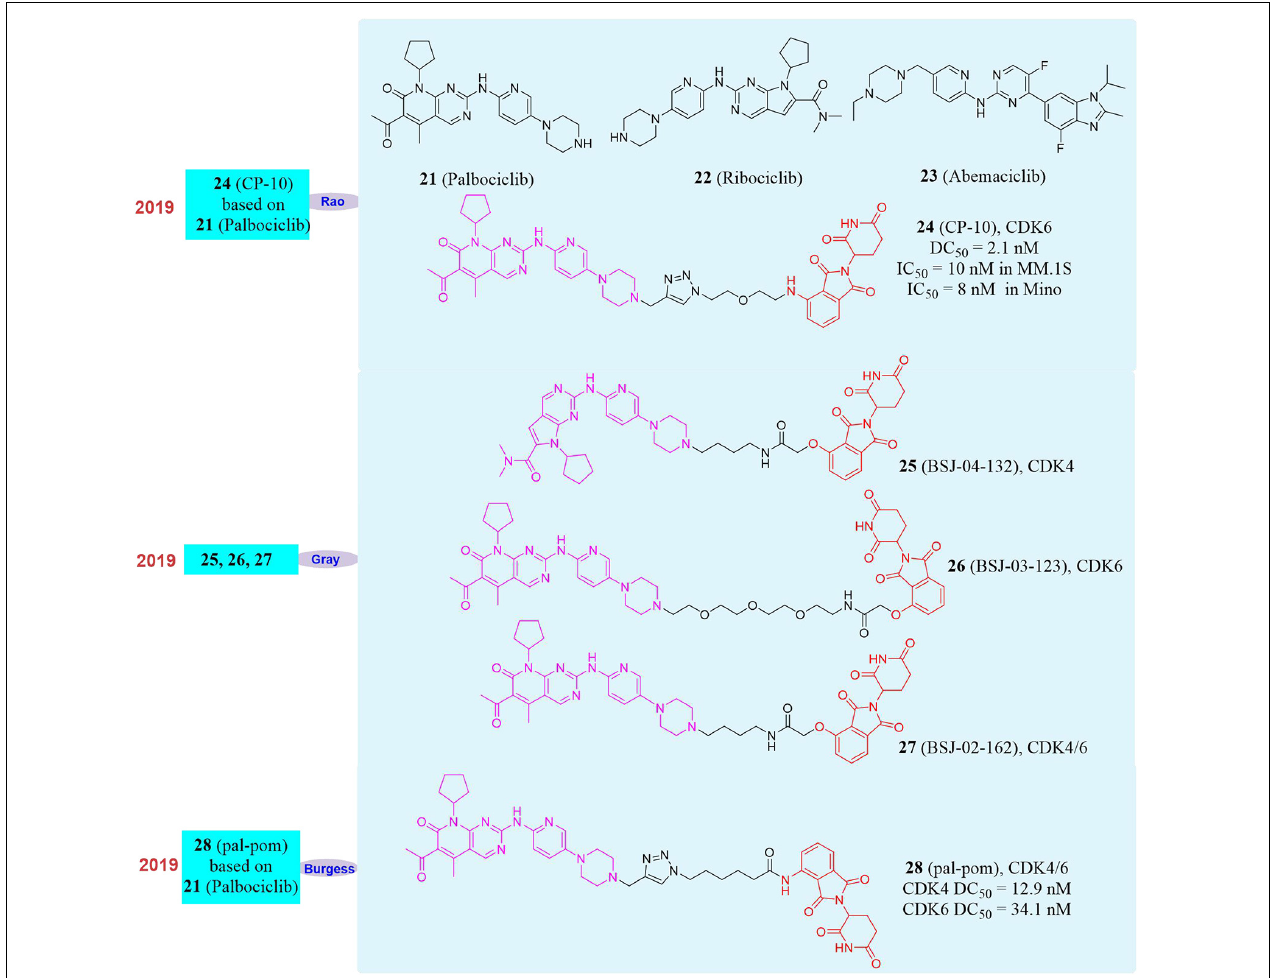
FIGURE 6 | Structures of CDK4/6 inhibitors and